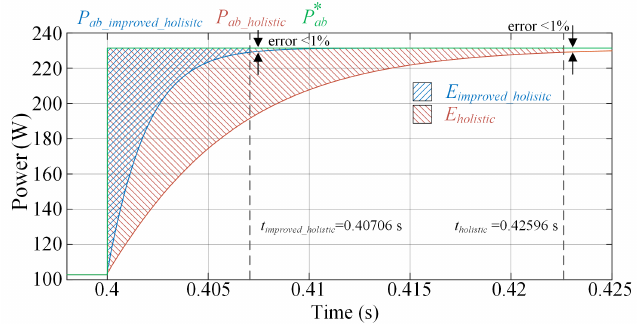
Figure 9. Change from ISM to GCI going from 411.4 W to 102.8 W, respectively.